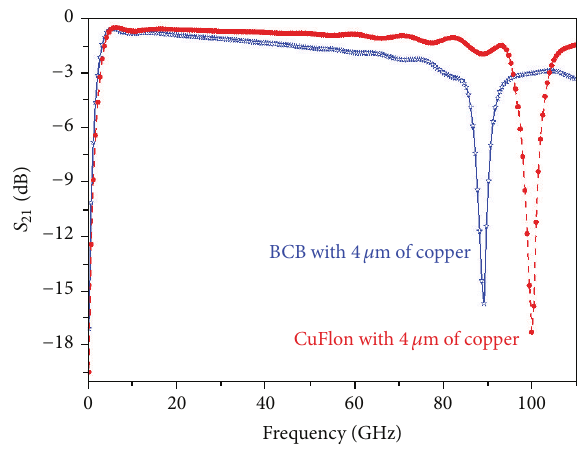
Figure 9: HFSS simulated 𝑆 21 transmission coefficient (dB) of via- free back-to-back transitions on polymer substrates CuFlon and BCB, both of 20 𝜇 m